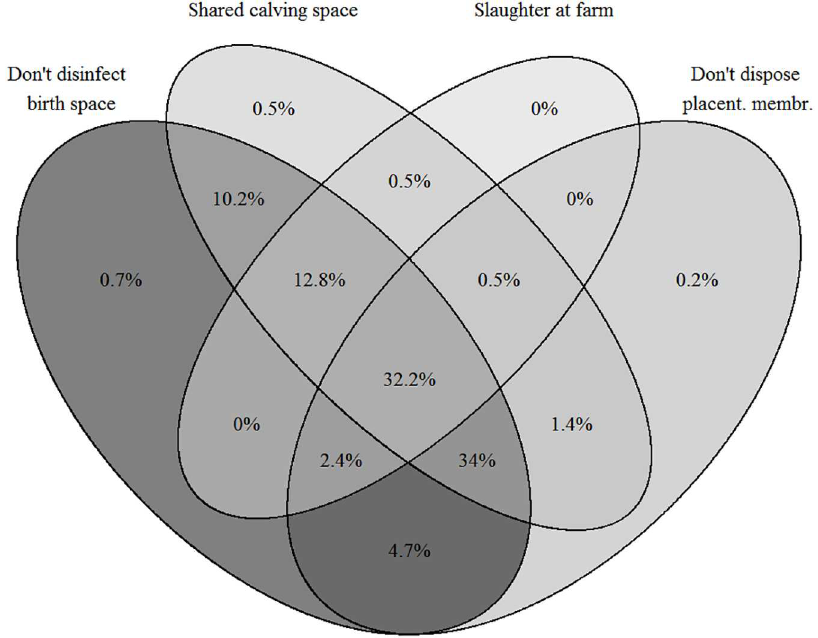
Fig 2. Venn diagram showing the percentages of smallholder dairy farmersin Pakistan having combinations of multiple herd management practicesposing a risk of brucellosis transmission within herd.